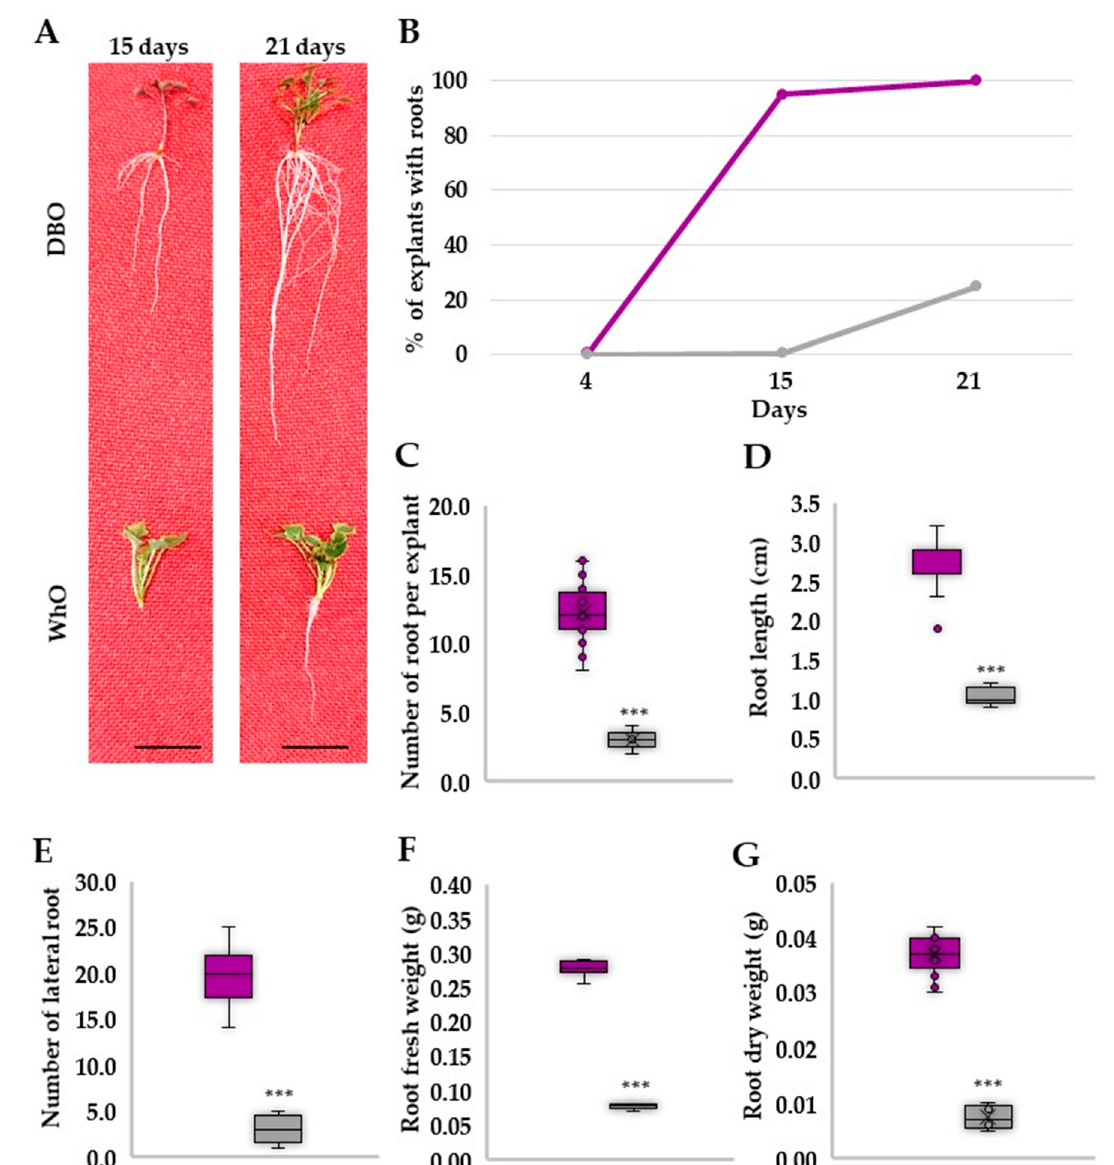
Figure 2. Adventitious root formation by Deep Blue Ocean (DBO) and White Ocean (WhO) genotypes Campanula portenschlagiana . ( A ) DBO and WhO genotypes at the fifteenth and twenty-first day after cutting. ( B ) Percentage of explants of DBO (dark purple line) and WhO (light gray line) with adventitious root at the fourth, fifteenth, and twenty-first day after cutting. ( C ) Average number of adventitious roots of DBO (dark purple box) and WhO (light gray box) at the twenty-first day after cutting. ( D ) Average root length (cm) of the adventitious root of DBO (dark purple box) and WhO (light gray box) at the twenty-first day after cutting. ( E ) Average number of lateral roots of DBO and WhO at the twenty-first day after cutting. ( F ) Average fresh root weight of DBO (dark purple box) and WhO (light gray box) genotypes at the twenty-first day after cutting. ( G ) Average dry root weight of DBO (dark purple box) and WhO (light gray box) at the twenty-first day after cutting. Scale bars: 0.5 cm. Error bars represent standard deviation. t- test significance: *** p < 0.001; n = 20. The data for genotypic differences in AR formation were previously presented at the 1st International Electronic Conference on Horticulture [27] .